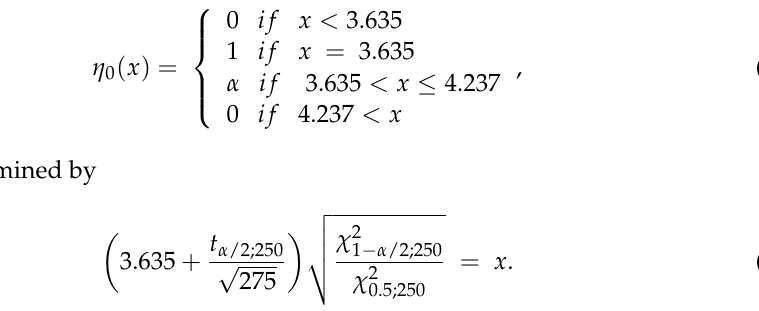
Figure 3 is a diagram of membership function η 0 ( x ) with ∆ (cid:101) x = ( 3.635, 4.237 ) and η ( x ) with ∆ (cid:101) C 0 = ( 3.599, 4.197 )